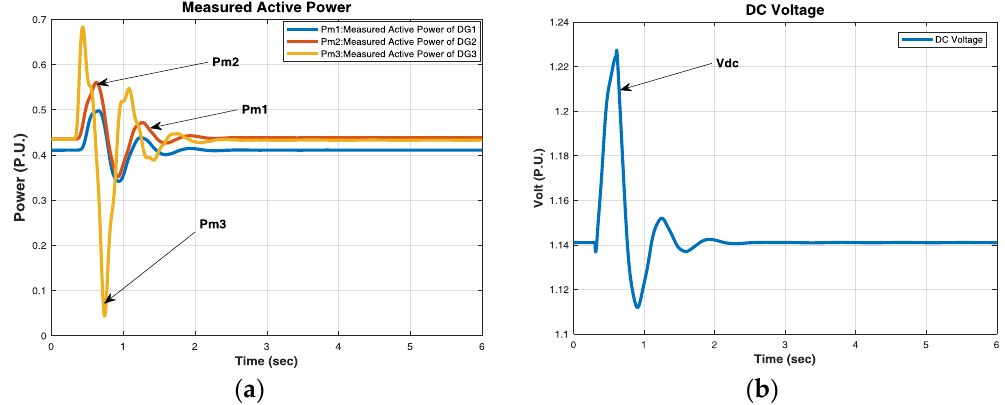
Figure 11. Microgrid response when the reference dc voltage stepped up by 5%. Figure 11 . Microgrid response when the reference dc voltage stepped up by 5%. Figure 11 . Microgrid response when the reference dc voltage stepped up by 5%.